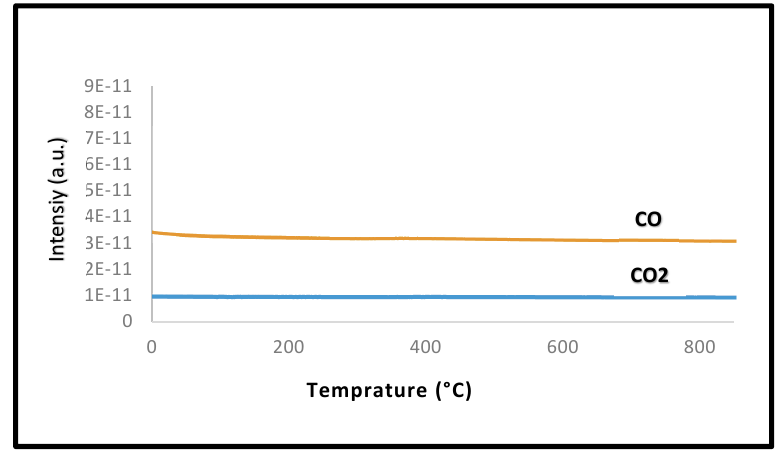
Figure 13. Temperature programmed oxidation TPO curves of spent Ni,Pd,Pt/Mg 0.85 Ce 4+0.15 O catalyst after reaction at T = 900 °C with ratio of 1:1 CH 4 /CO 2 . and GHSV = 15,000 mL h − 1 g − 1 cat.